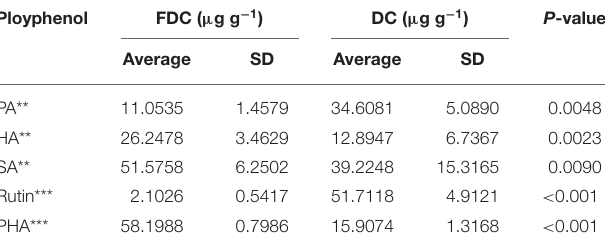
TABLE 1 | Contents of five phenolic substances in FDC and DC.